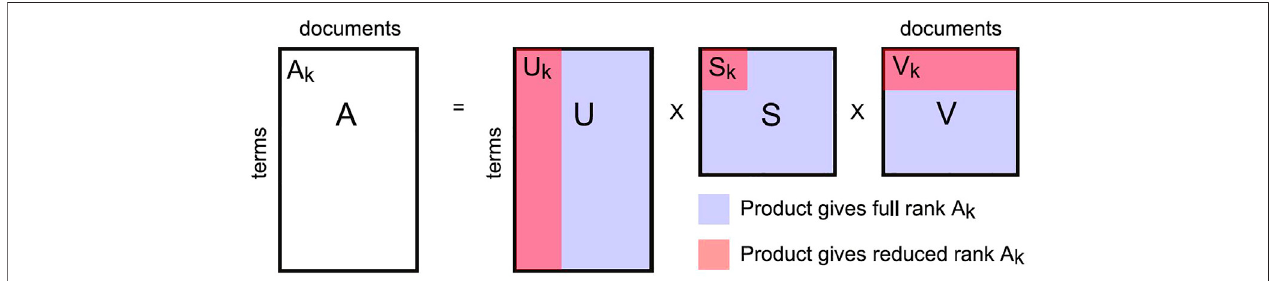
FIGURE3| MatrixfactorizationforLSA.Thenormalizedterm-documentmatrixAcanbeexpressedastheproductofthreematrices(U,S,V).Toreducetherankof matrix A (and hence alleviate the issues of sparsity and neglect of higher order term co-occurrences) the product can be re-computed retaining only the k principal submatrixofS(thusrestrictingUandVtotheir fi rstkcolumnsandrows,respectively).Parameterkisrelatedtotheestimatednumberoflatentsemanticdimensionsinthe corpus (Landauer et al.,